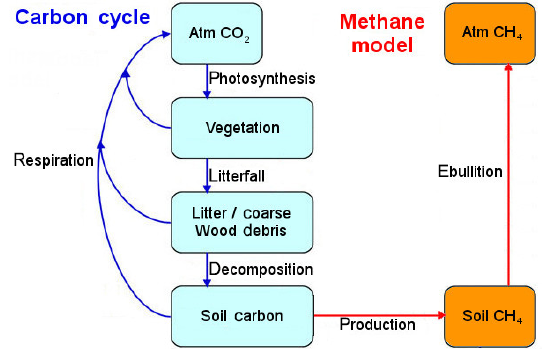
Figure 3. Schema of the carbon flux in CLM4.5-BGC. Figure re- drawn from Oleson et al.